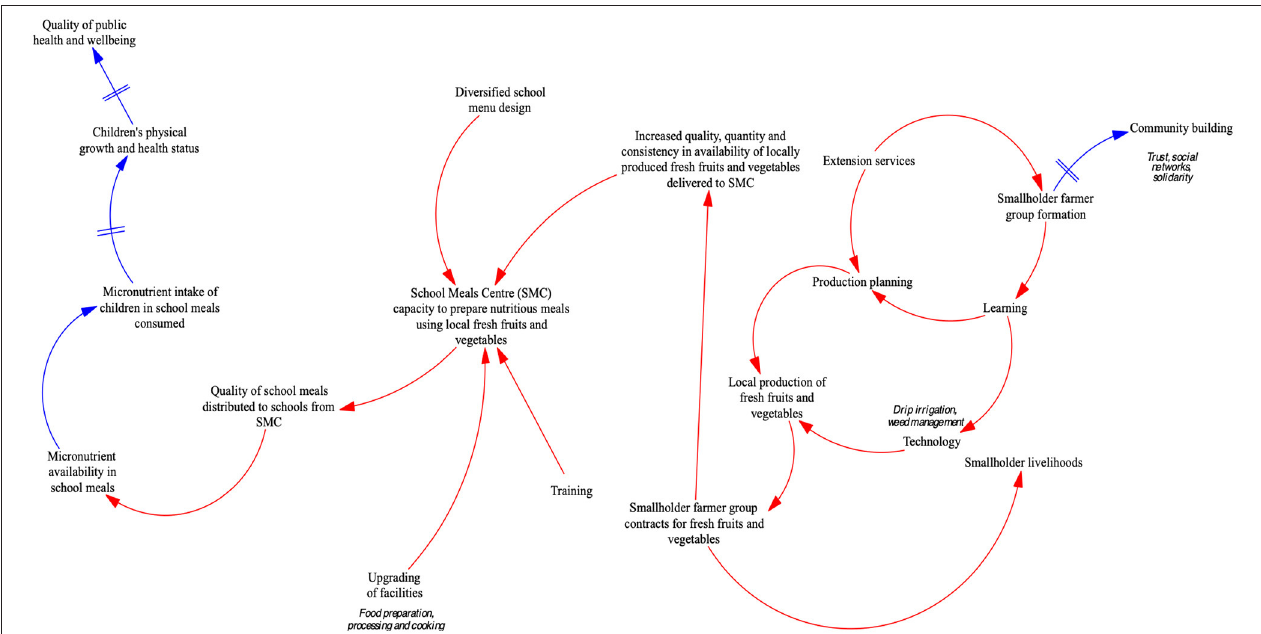
FIGURE 1 | Causal map showing the F2F theory of change, linking project interventions (red arrows) to anticipated outcomes (blue arrows). The ToC assumed a generally positive and linear impact pathway for improving nutrition outcomes. Double parallel lines indicate time delays in achieving anticipated outcomes.